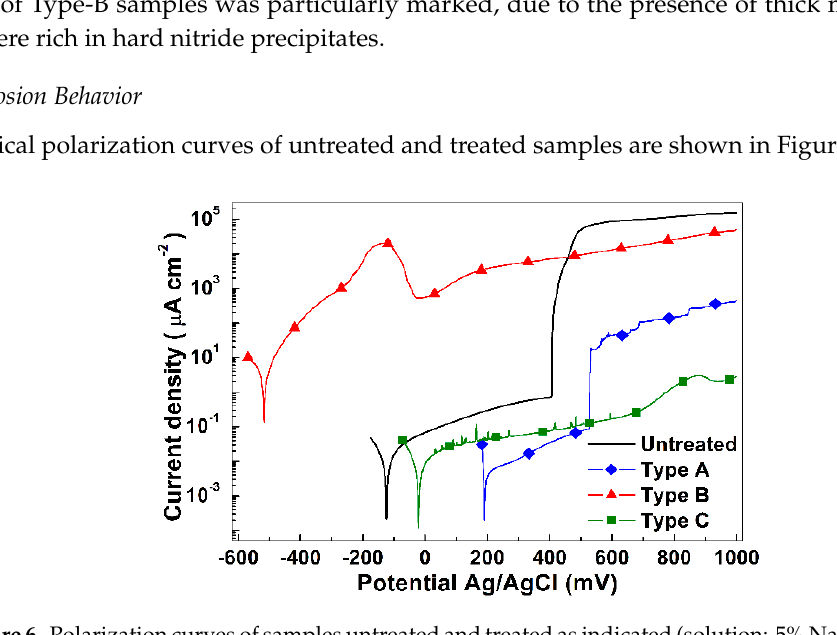
Table 3. Surface Knoop microhardness values of samples untreated and treated as indicated (test loads: 10 and 25 gf).